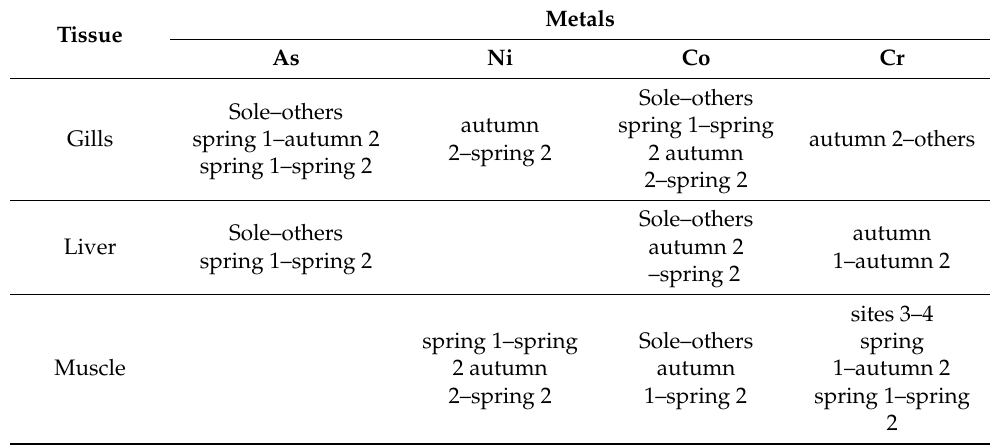
Table 6. Significant differences among sites and samplings in fish from Algeciras